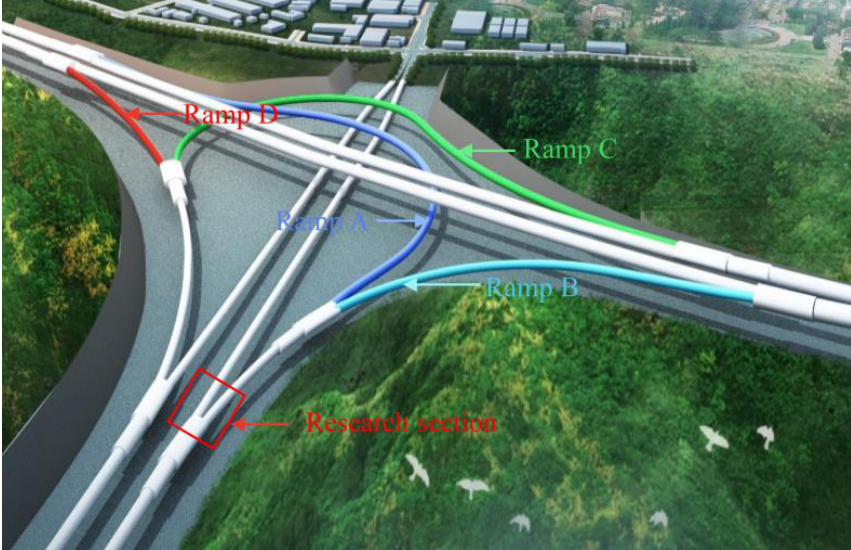
Figure 1. Schematic diagram of the underground interchange hub including the evacuate channel and Luao Road.